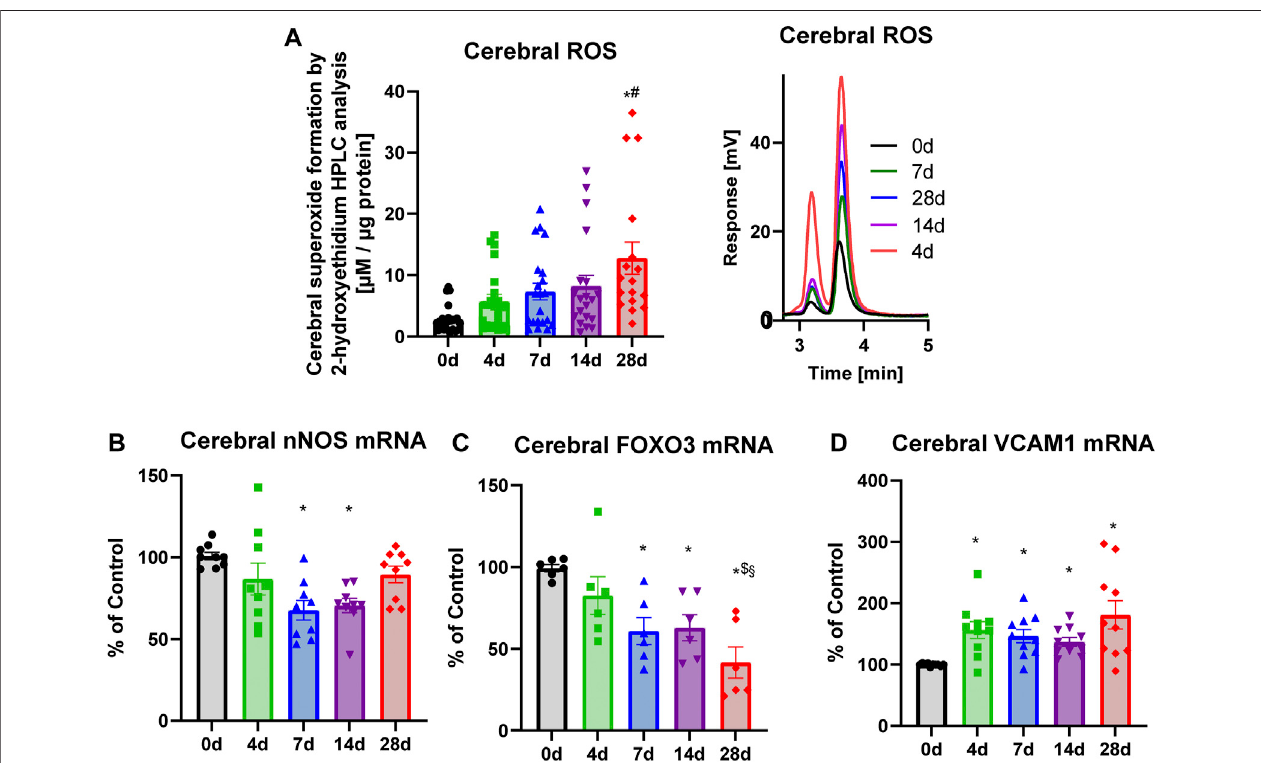
FIGURE 7 | Effects of long-term noise aircraft exposure on noise-induced side effects in the brain. (A) Similar to superoxide measurements in aorta and blood, brains of noise-exposed mice displayed a progressively increasing superoxide formation. Representative chromatograms for measurements are alongside the quanti fi cations. (B) mRNA isolated from these brains revealed adown-regulated Nos3. (C) Evidence for adecreased antioxidant transcription factor Foxo3 and with the consequence of a disruption of the circadian rhythm. (D) Vcam1 was consistently upregulated in all exposure groups. Data points for (A) represent individual animals, n (cid:1) 22 – 23. Data points from (B,C,D) represent pools of tissue from two to three animals. Statistical analysis with one-way ANOVA with Tukey ’ s multiple comparison test. p < 0.05: * vs respective to 0d, # to 4d, $ to 7d, § to 14d and + to 28d.